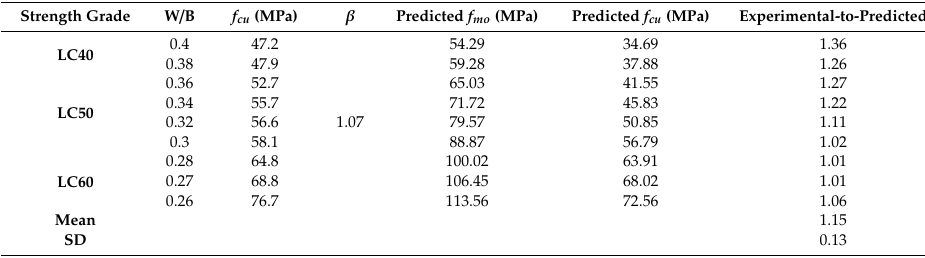
Table 8. Comparison of test and estimated